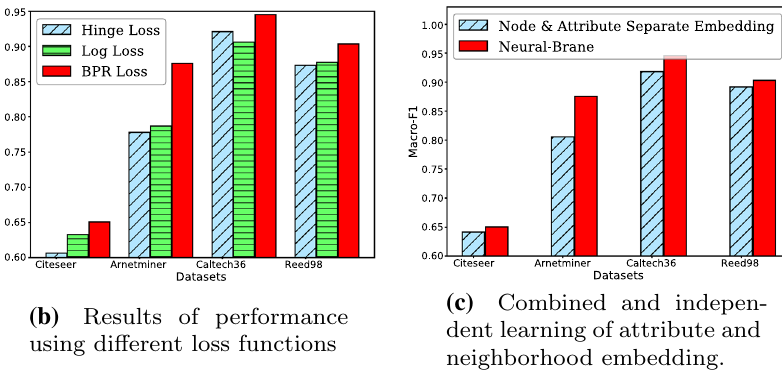
Fig. 7 Scalability study and importance of BPR loss and other layers of the